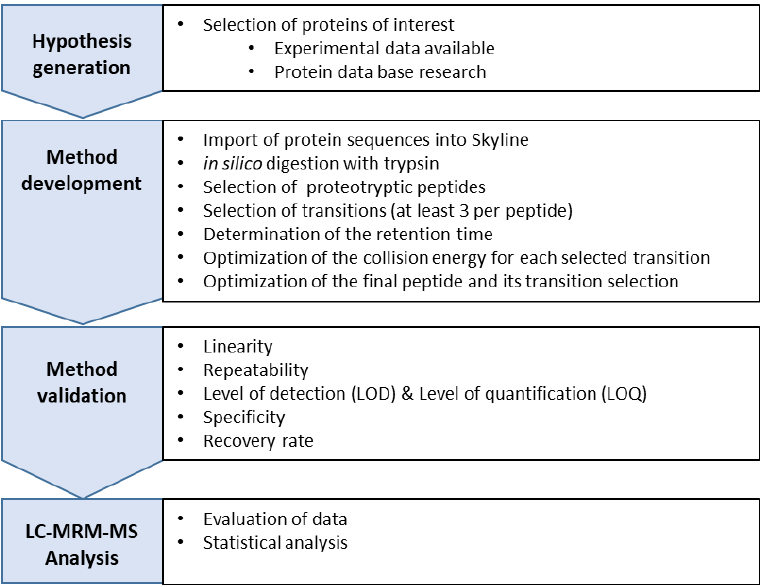
Figure 2. Workflow for developing a Multiple Reaction Monitoring (MRM) assay using a high performance liquid chromatography mass spectrometry HPLC-MS/MS.